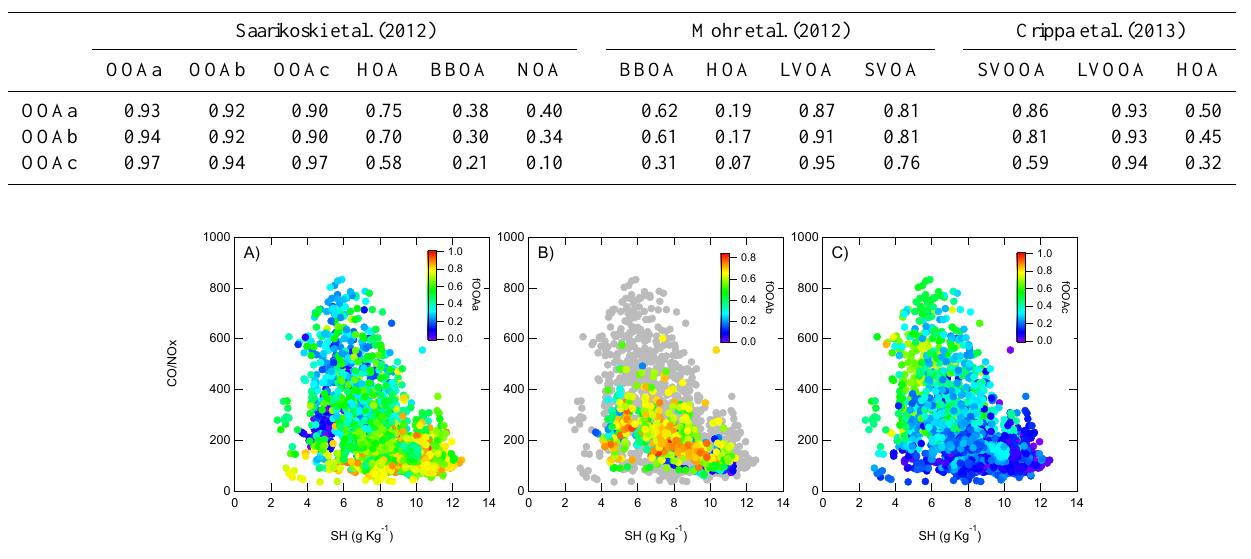
Figure 10. CO / NO x ratio vs. SH, colour-coded by the contribution of factors (a) OOAa, (b) OOAb and (c) OOAc. In panel (b) only the data points corresponding to OOAb maximum contribution period (17–23 June) have been coloured, to make the plot clearer.